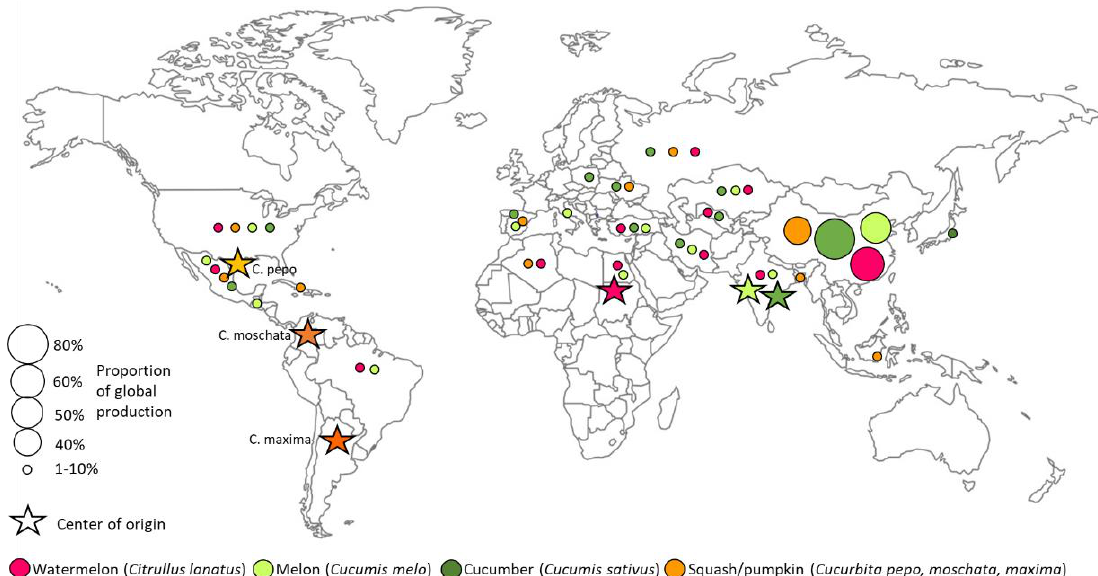
Figure 2. Regions of production and origins of domestication of major cucurbit crops: watermelon ( Citrullus lanatus ), melon ( Cucumis melo ), cucumber ( Cucumis sativus ), pumpkins/squashes ( Cucurbita pepo, moschata, maxima ). Circle size reflects relative proportion of worldwide production.